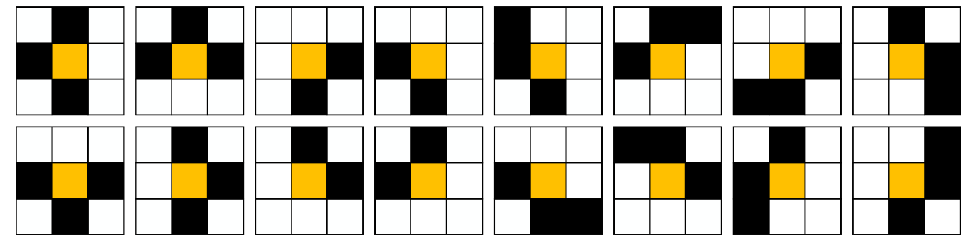
Figure 8. Non-single pixel skeletons generated by Zhang–Suen algorithm.